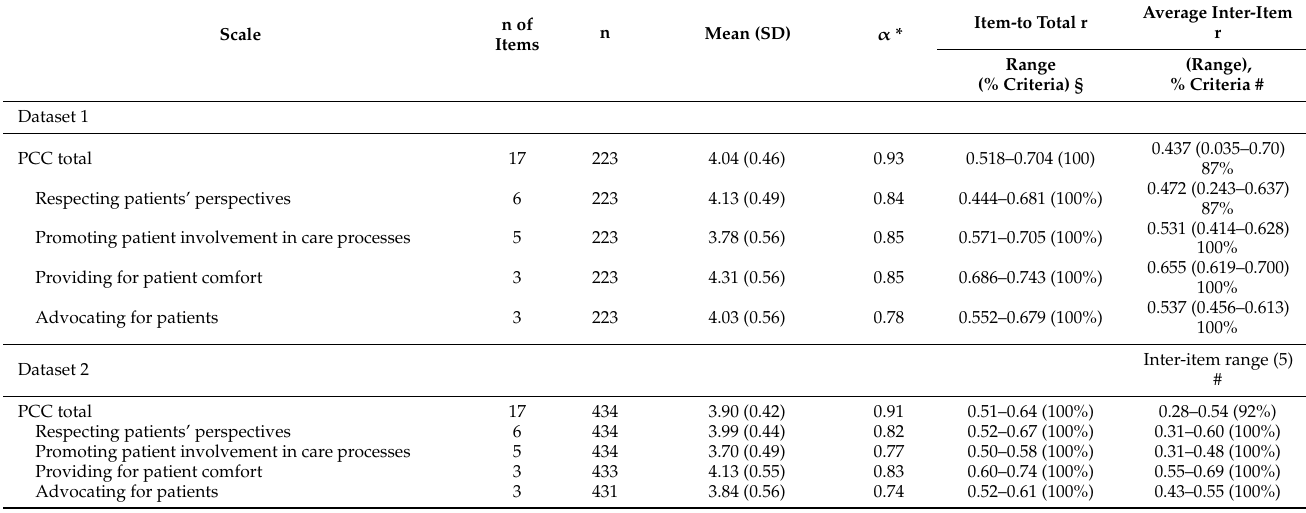
Table 1. Descriptive statistics of the Patient-centred Care Competency (PCC) total and sub-scales, Cronbach’s alpha and item analysis.